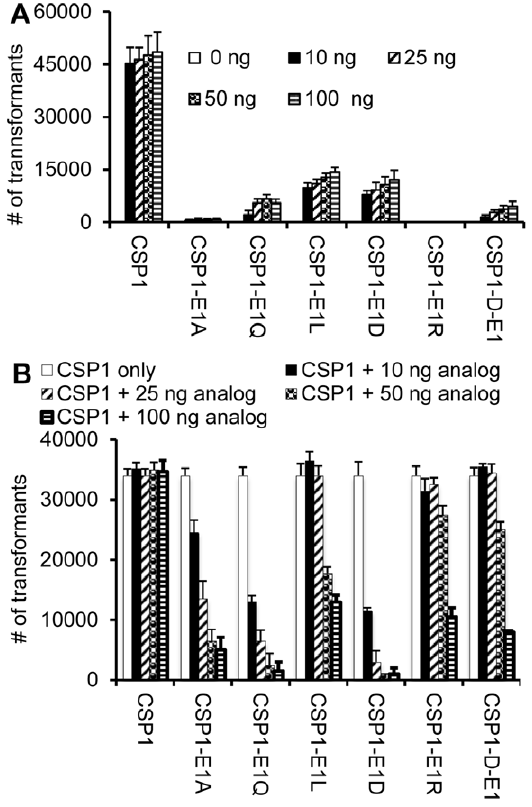
Figure 6. Competitive inhibition of CSP1 by low concentrations of analogs with substitutions of glutamate residue in the first position. (A) Induction of genetic transformation by each analog using the genomic DNA containing the rpsL gene. Transformants were selected on THB agar containing 100 m g/ml streptomycin. Experiments were performed in triplicates and repeated three times. The means 6 SD of one typical experiment are shown. (B) Competitive inhibition of genetic transformation by low concentrations of CSP1 analogs. Genetic transformation was performed using the genomic DNA containing the rpsL gene. Transformants were selected on THB agar containing 100 m g/ ml streptomycin. Experiments were performed in triplicates and repeated three times. The means 6 SD of one typical experiment are shown.